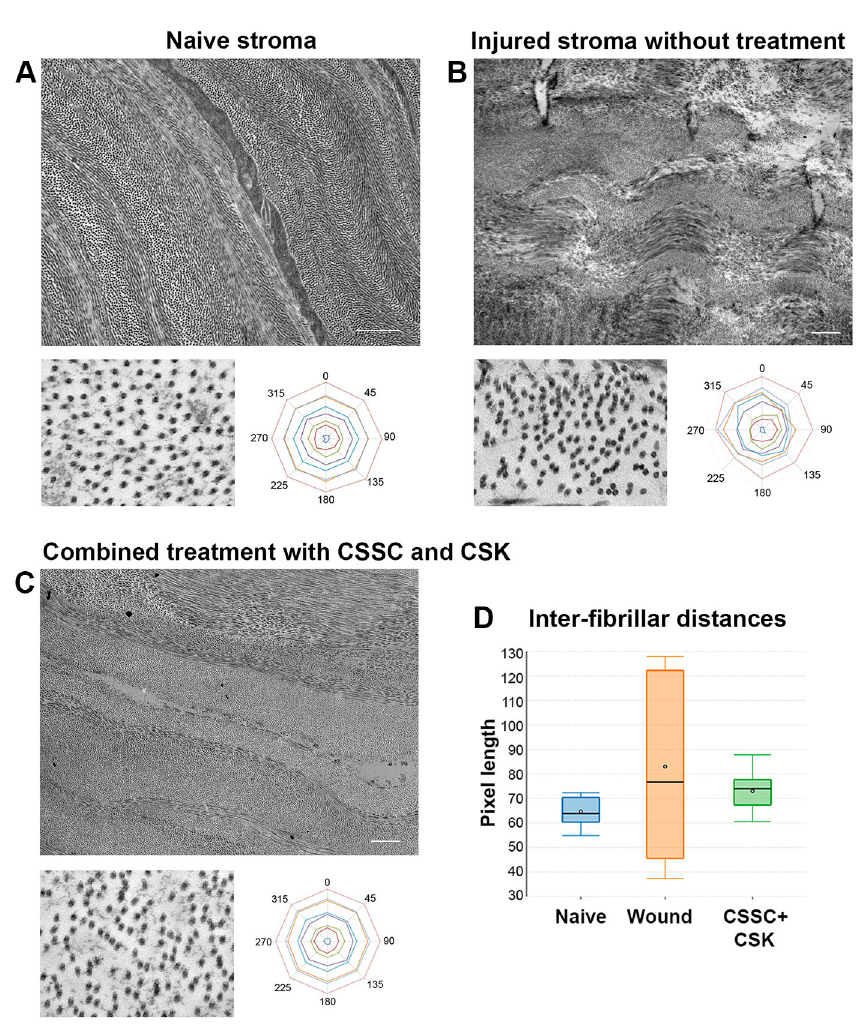
Figure 8. Transmission electron microscopy analysis of mouse corneas after combined CSSC and CSK treatment. ( A ) Naïve stroma with regularly aligned collagen fibrils and balanced fibrillar configuration. ( B ) Scarred stroma with variable collagen packing and irregular fibril distribution. ( C ) Corneas after combined cell treatment had compact collagen organization with a more consistent fibril arrangement. ( D ) Scarred stroma showed a wider range of interfibrillar distances than naïve stroma. Cell-treated stroma showed a similar narrow range of distances; scale bars: 2 μ m.